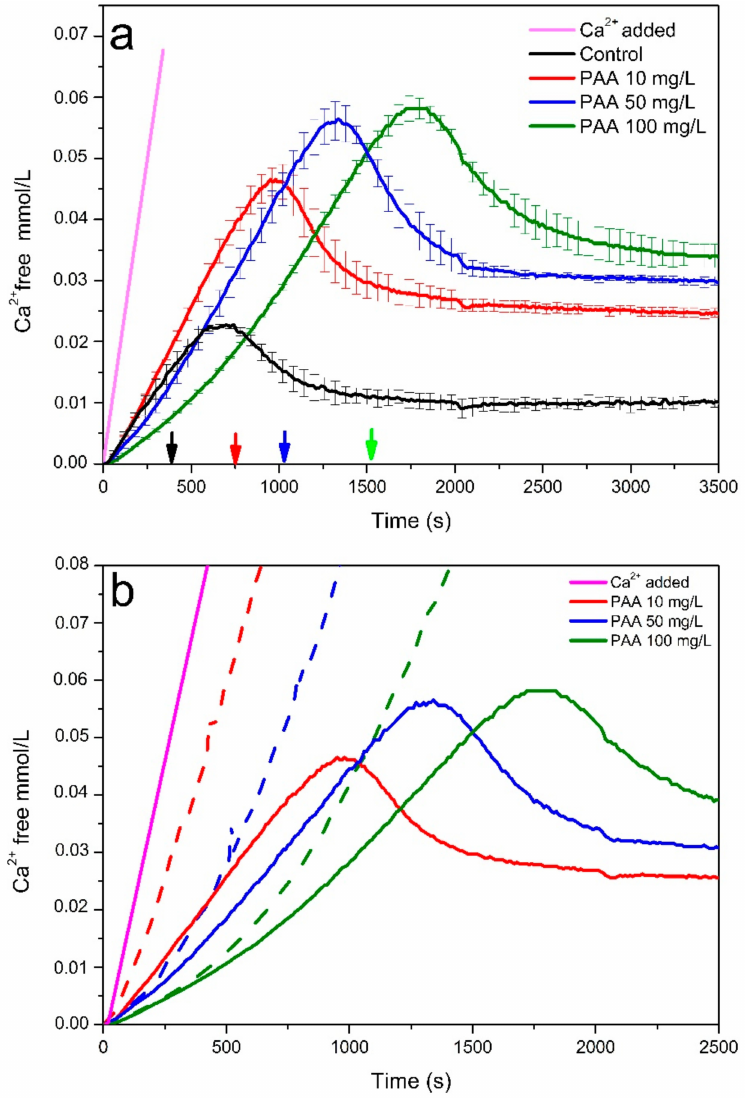
Figure 1. Time development of free Ca 2+ ion concentration in titration experiments of CaOx (solid line) and pure water (dashed line) in the absence and presence of three concentrations of PAA as additive. ( a ) Titration experiments of CaOx. ( b ) Titration experiments of CaOx and pure water. Each vertical arrow indicates the corresponding sample collection time for TEM